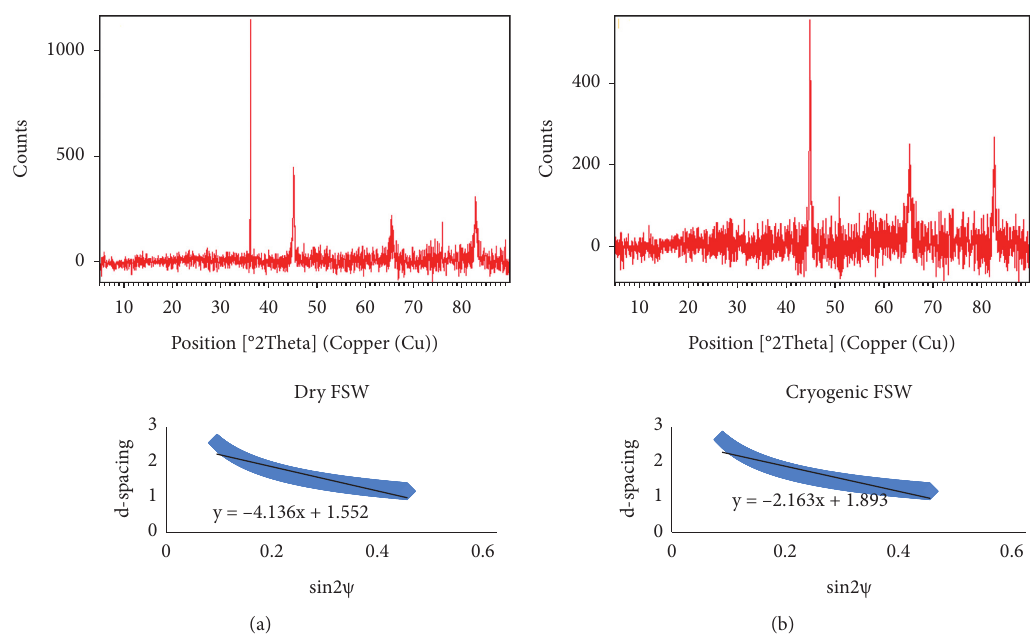
Figure 22: XRD image of (a) dry and (b) cryogenic friction stir-welded AA 7075 aluminium alloys.